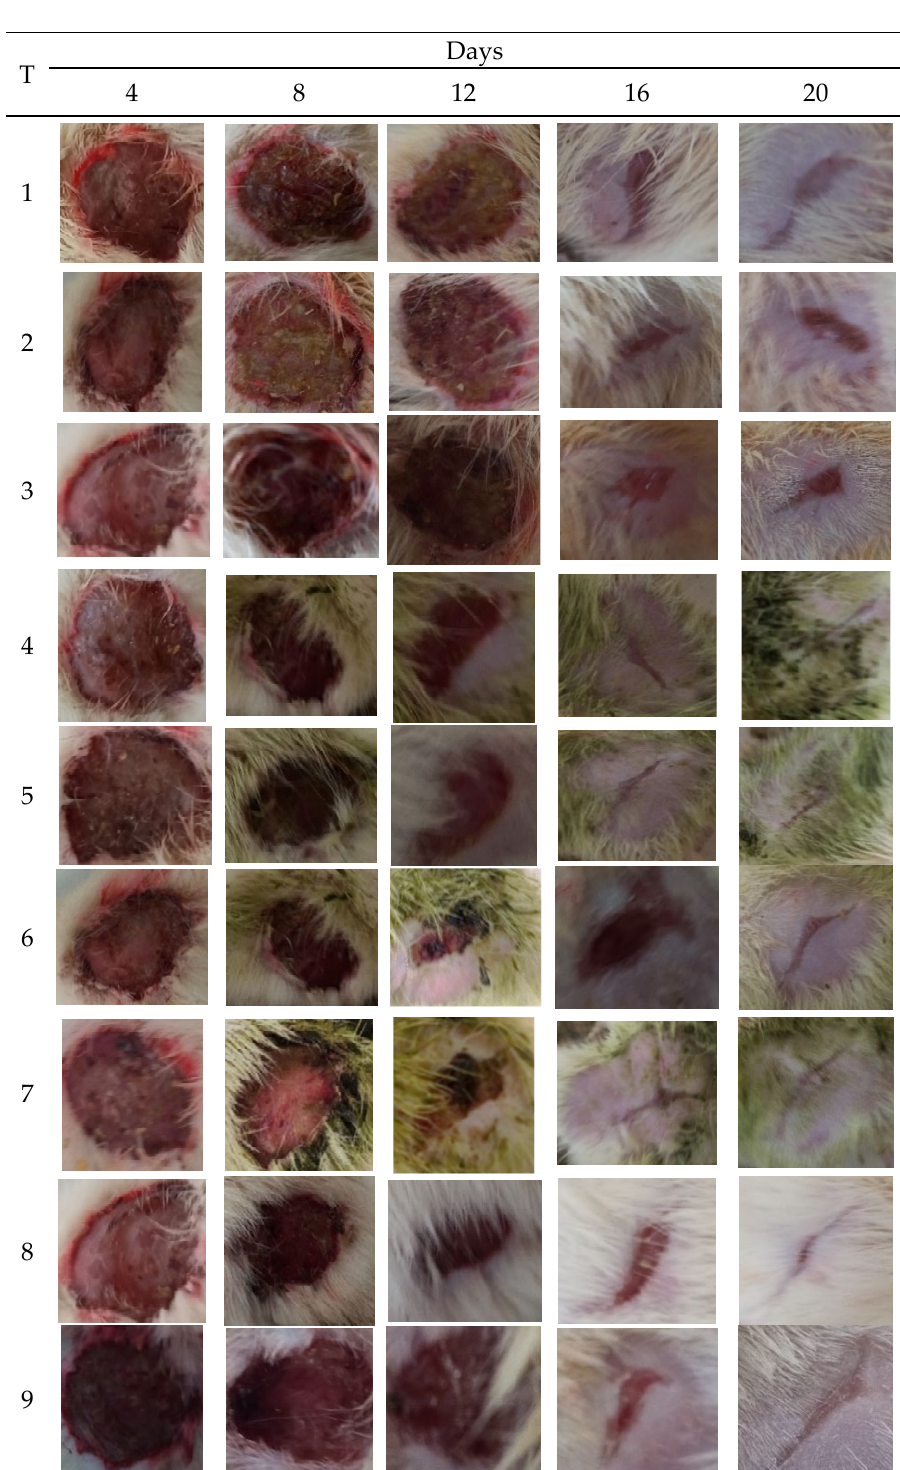
Figure 3. Images of wounds infected with bacterial pathogens treated with different concentrations of M. oleifera extract, along with control. Treatments: 1. Ointment base 2. MRSA ‐ infected wound treated with ointment base; 3. P. aeruginosa infected wound treated with ointment base; 4. MRSA ‐ infected wound treated with 10% extract; 5. MRSA ‐ infected wound treated with 20% extract; 6. P. aeruginosa ‐ infected wound treated with 10% extract; 7. P. aeruginosa ‐ infected wound treated with 20% extract 8;. Infected with MRSA and treated with mupirocin (positive control); 9. Infected with P. aeruginosa and treated with gentamicin (positive control).